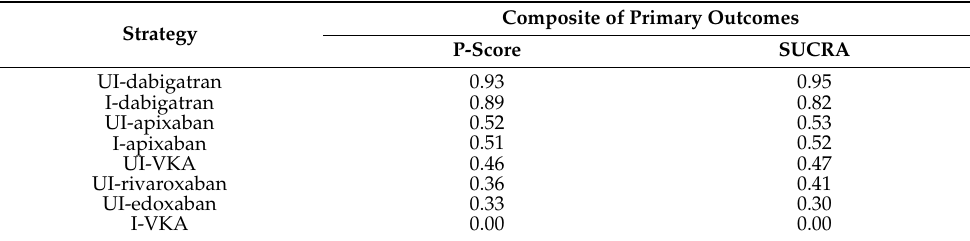
Table 3. P-score and the SUCRA values for each strategy and composite of primary outcome.